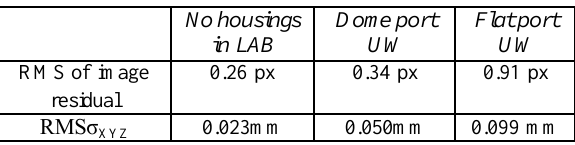
Table 1. Summary of the self-calibrating bundle adjustment.